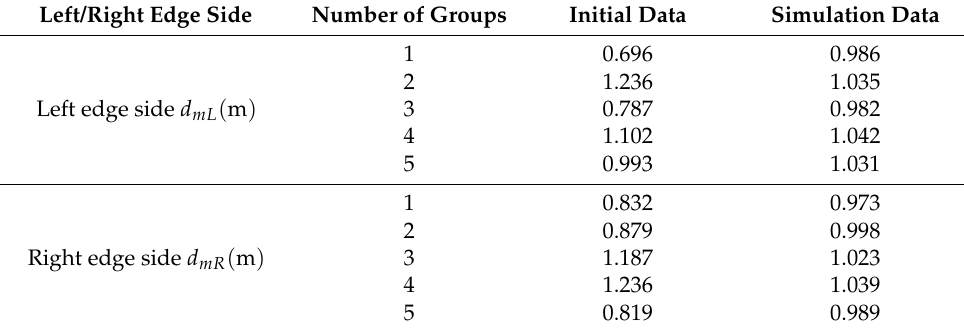
Table 4. Experimental data of